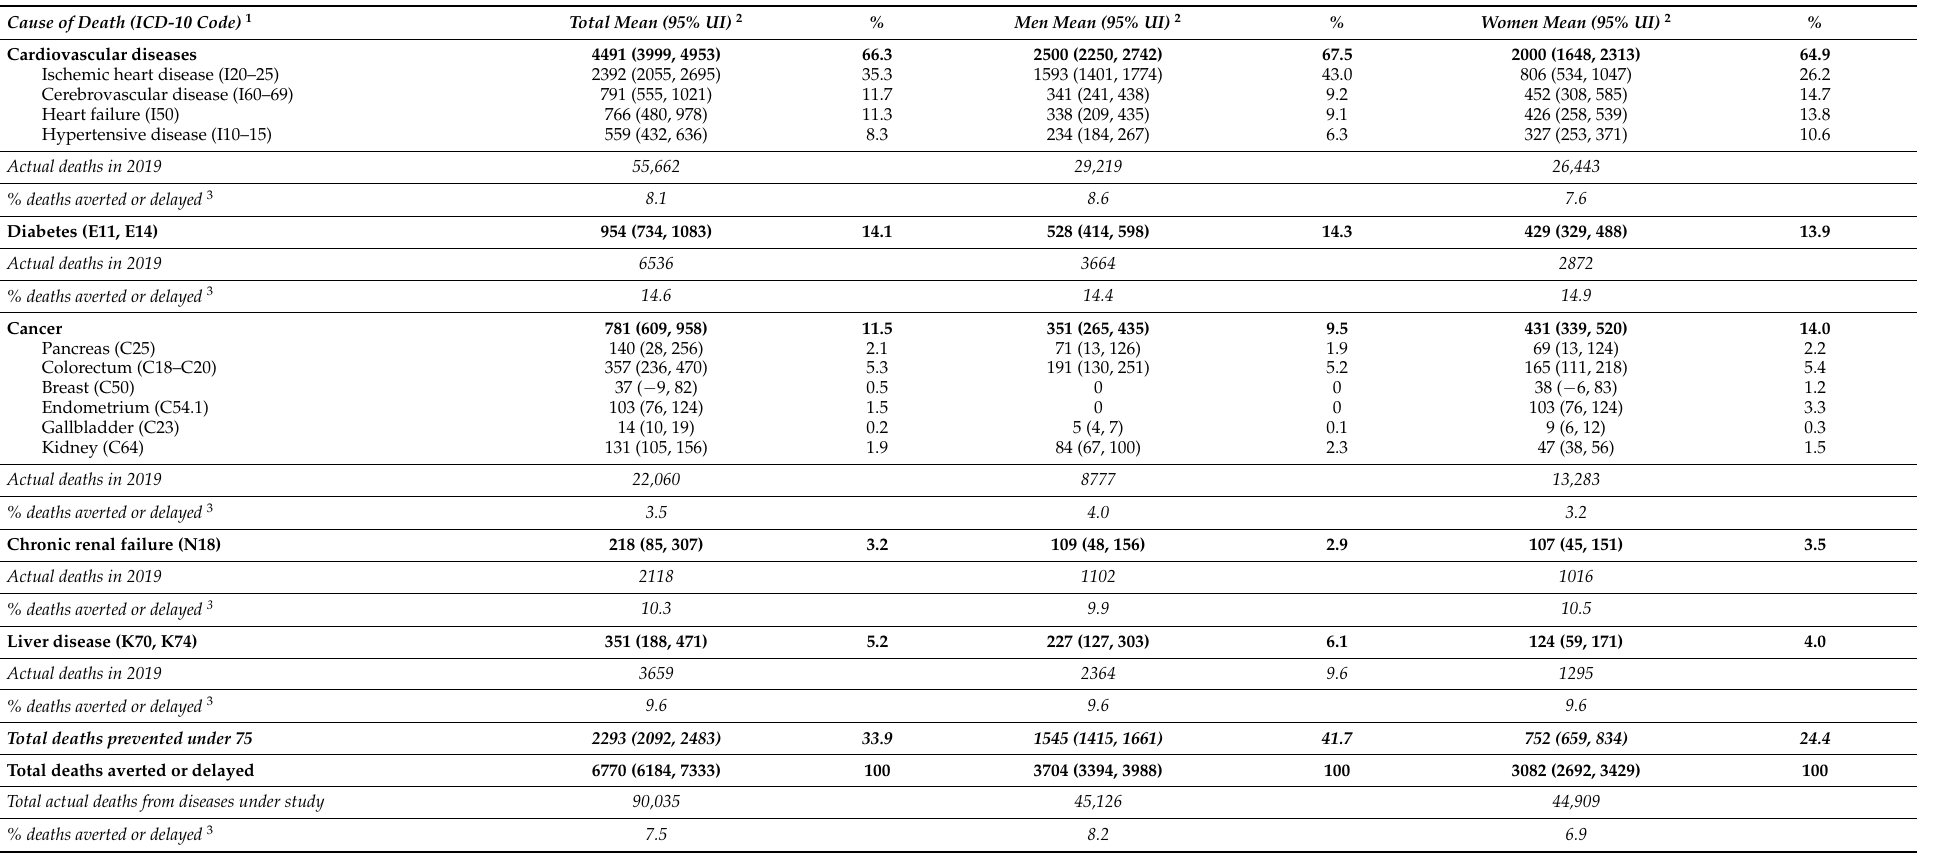
Table 2. Estimated number of deaths that could be averted or delayed if Canadians reduced their consumption of calories derived from free sugars intake as a result of reducing free sugars content in packaged food products by 20%—by cause of death (95%